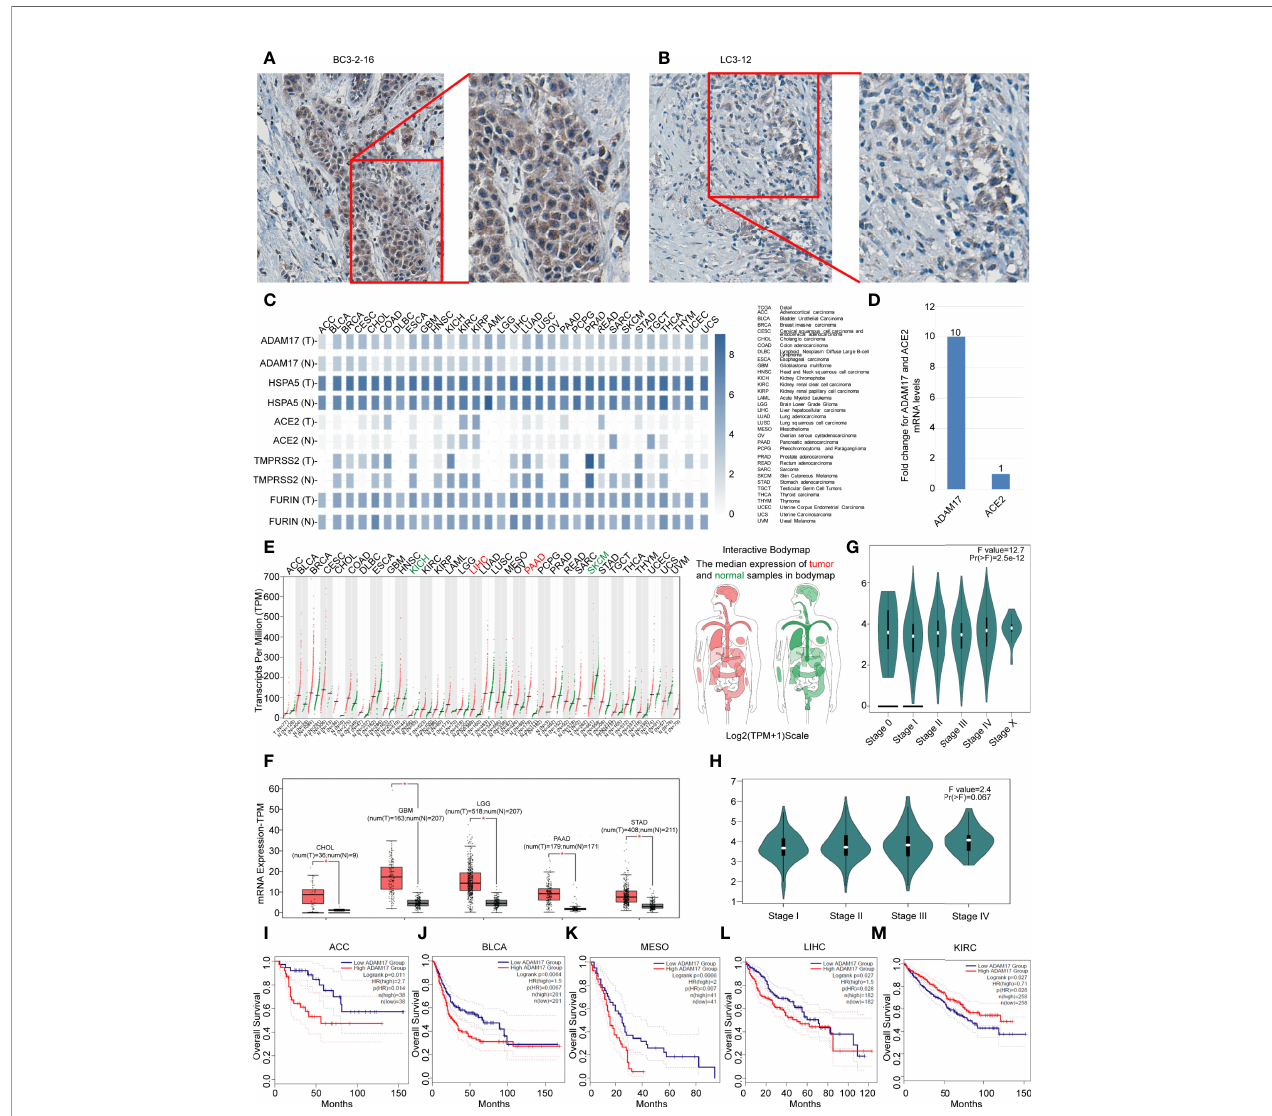
FIGURE 4 | Differential expressions of ADAM17, HSPA5, ACE2, FURIN, and TMPRSS2 in tumors and corresponding normal tissues, and prognostic values of ADAM17 expression in multiple cancer types. (A) The representative IHC images of tumors from Chinese breast cancer patients. (B) The representative IHC images of tumors from Chinese lung cancer patients. IHC was performed by ADAM17 antibody (HPA010738, Sigma-Aldrich). B&D, enlarged images from A&C respectively. (C) Expression comparisons of ADAM17 with HSPA5, TMPRSS2, FURIN, and ACE2 in 31 types of normal and cancer tissues. “ T ” stands for tumors, whereas “ N ” denotes matched normal tissues. The cancer types of full names are shown on the right panel. (D) mRNA comparison between ADAM17 and ACE2 in lung cancer from the TCGA dataset. (E) The ADAM17 expression pro fi les across all cancers and paired normal individuals of tissues with dot plots. (F) ADAM17 was overexpressed in 5 cancer types with box plots. ADAM17 mRNA levels in cancers and matched normal individuals of tissues were obtained through the dataset of GEPIA. * P <0.05. (G) Pathological stage plots in pan-cancer. Pr(>F), 2.5e-12. (H) Pathological stage plots in LUAD. Pr(>F), 0.067. (I-M) The prognostic values for ADAM17 in fi ve cancer types from the GEPIA dataset. I-M indicates ACC, BLCA, MESO, LIHC, and KIRC. * P < 0.05. The cancer types of full names are presented on the right panel of Figure 4C . HR, Hazards Ratio. GEPIA, Gene Expression Pro fi ling Interactive